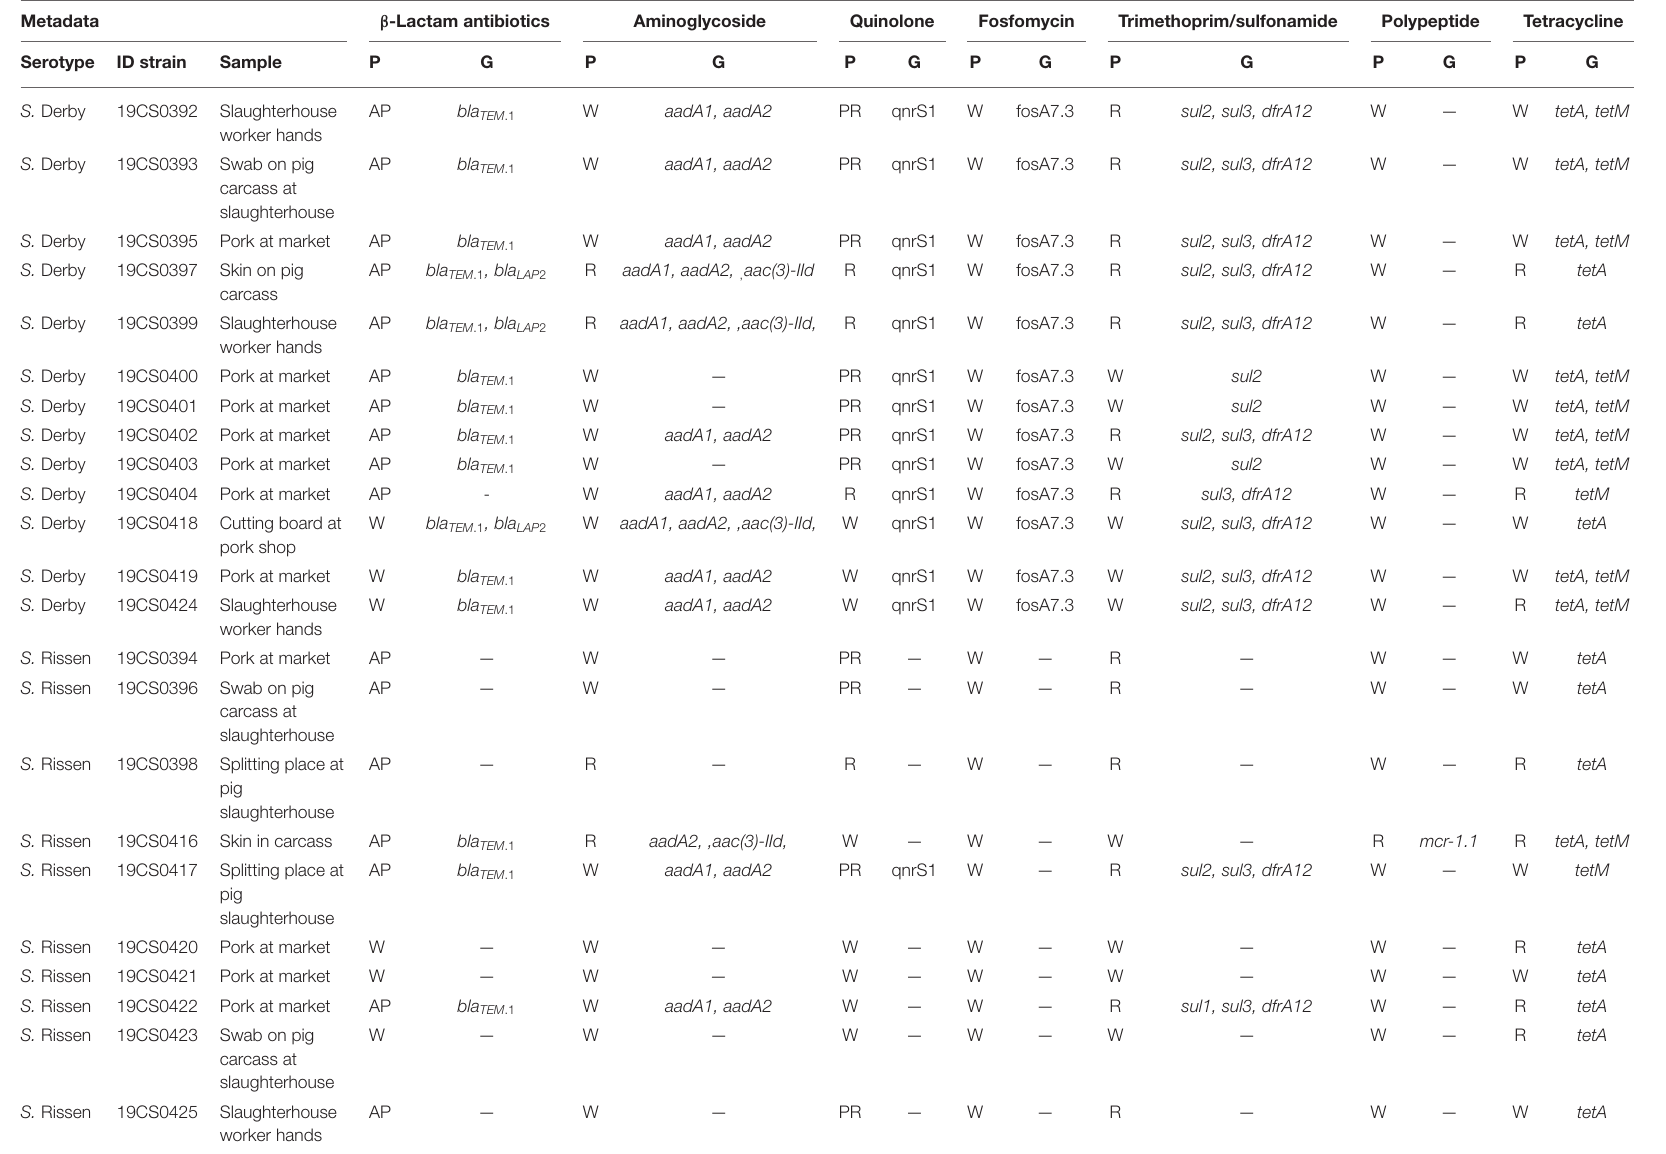
P, phenotype determinate by VITEK Compact 2; G, genotype determinate by ResFinder; AD, acquired penicillinase; W, wild type; R, resistance; PR, partial resistance; I,